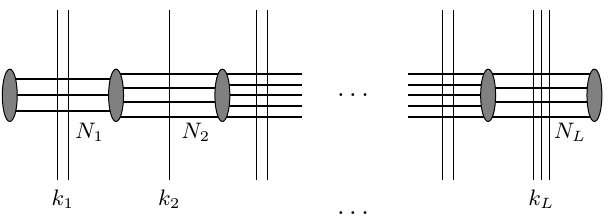
Figure 1 . Brane construction for the quiver gauge theories in (2.1). The vertical lines represent D5- branes oriented along the (012456) directions, the ellipses are NS5-branes oriented along (012789) and the horizontal lines are D3-branes extending along